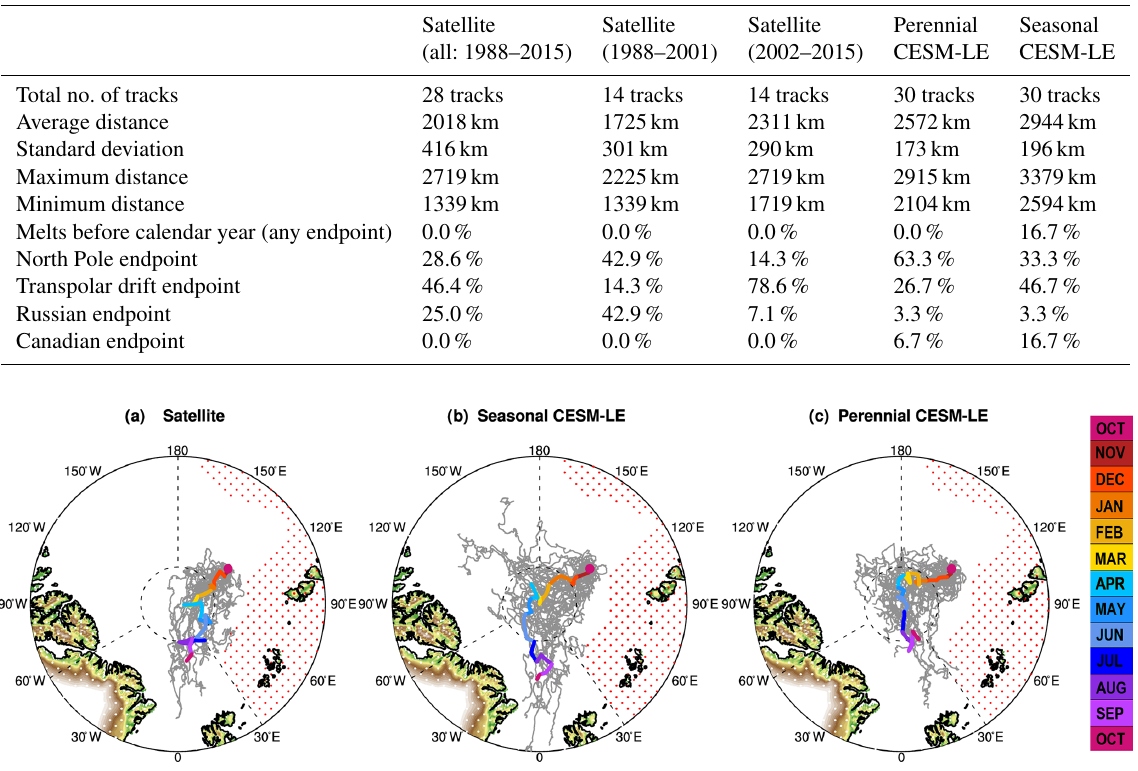
Figure 1. Unique ice floe tracks (grey) for satellite observations (a) , seasonal (b) and perennial (c) CESM-LE ensembles. Representative tracks (colored with corresponding months shown at far right) based on the individual tracks are overlaid. Dashed lines indicate boundaries for the Transpolar Drift, North Pole, Russian, and Canadian sectors described in Table 1. The Russian exclusive economic zone (EEZ) is shown by red